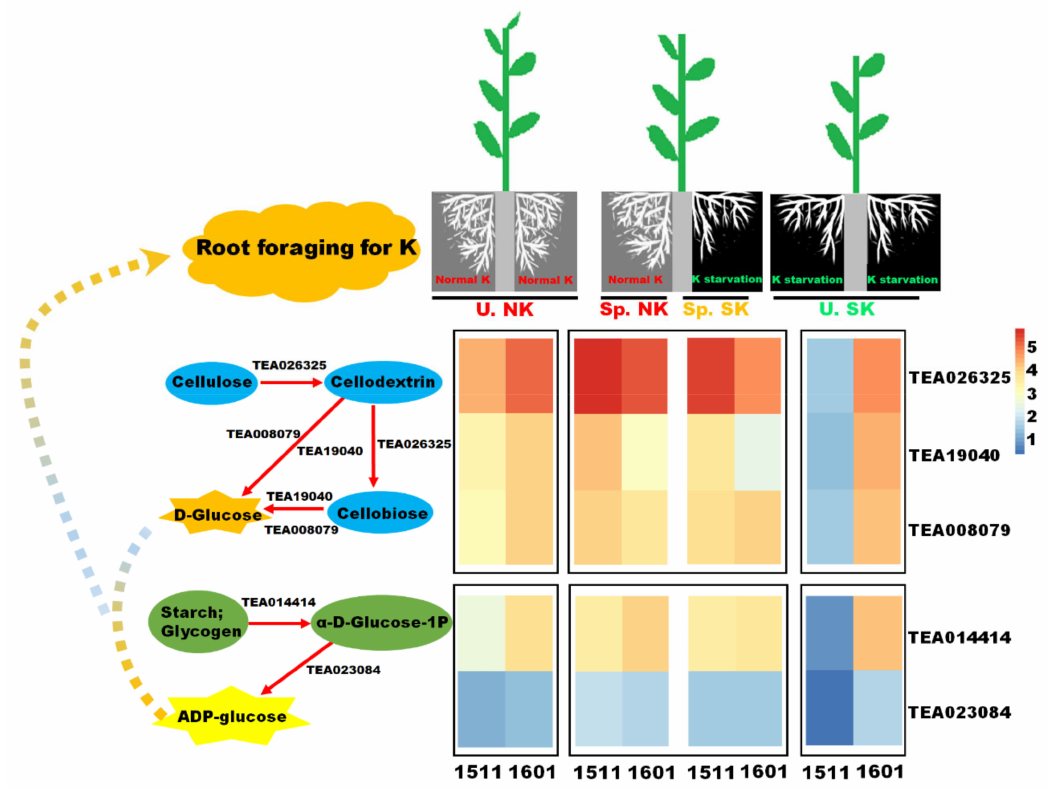
Figure 8. Relationships and expression patterns of the key genes enriched in the starch and sucrose metabolism pathway in heterogeneous vs. homogeneous K